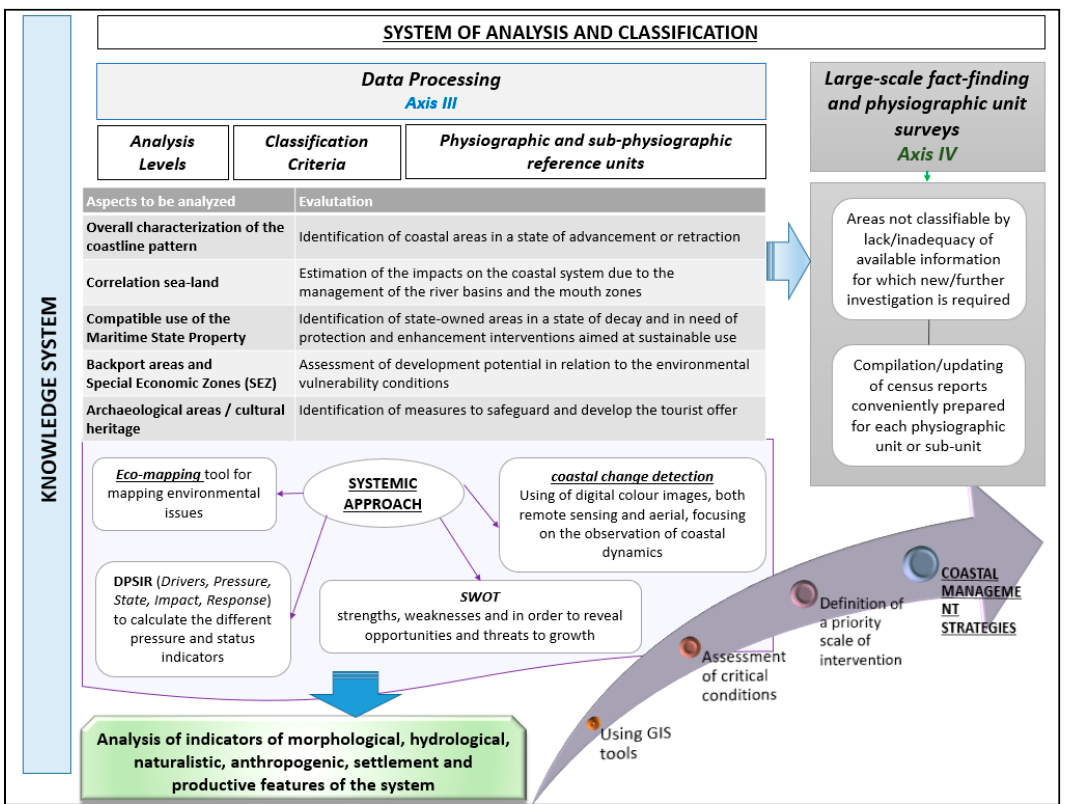
Figure 5. Schematic view of contents of the analysis and classification system.